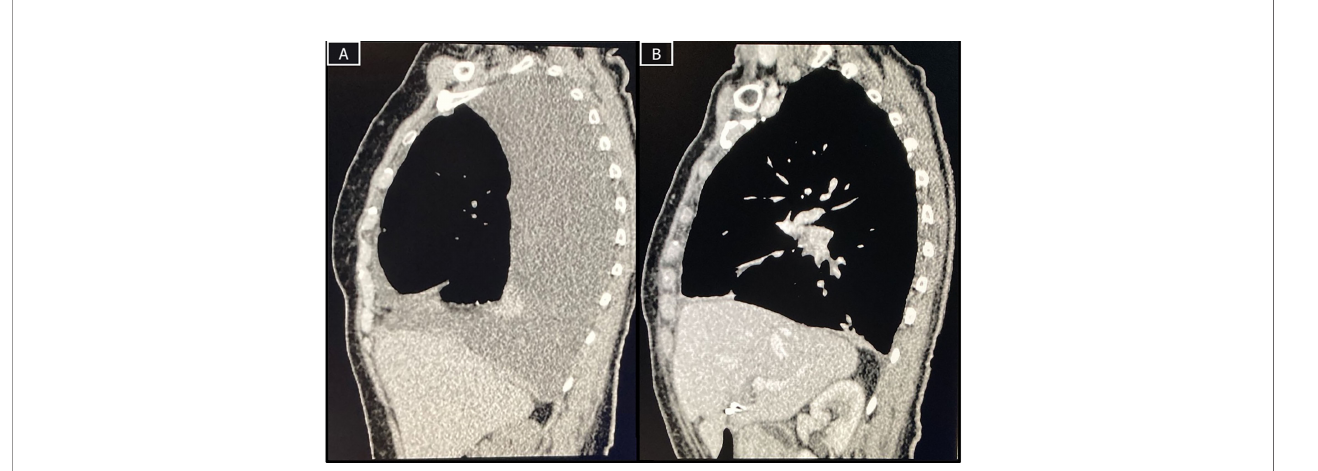
FIGURE 1 | CT-scans at baseline and after surgery. (A) Baseline CT-scan demonstrating pleural effusion, thickening and nodules and a rounded atelectasis; (B) Restaging CT-scan with improvement of pleural effusion and minimal focal pleural